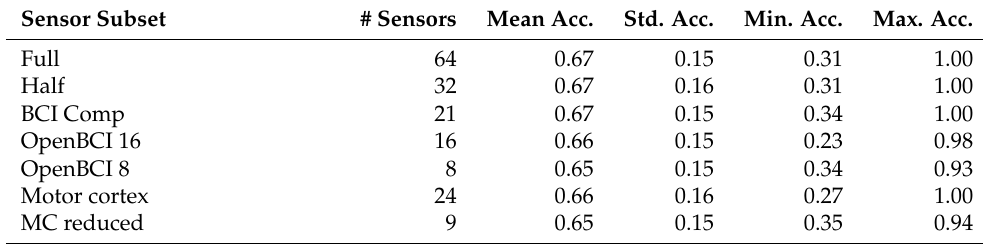
Table 1. Overview of mean cross-validation accuracy results for each considered sensor subset.